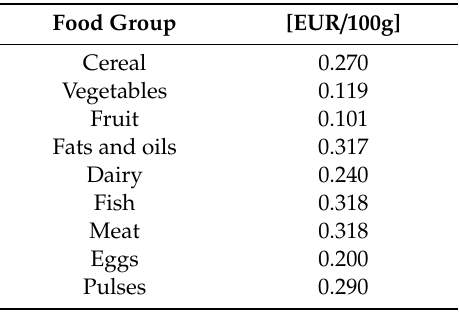
Table 4. Median price of di ff erent food groups.